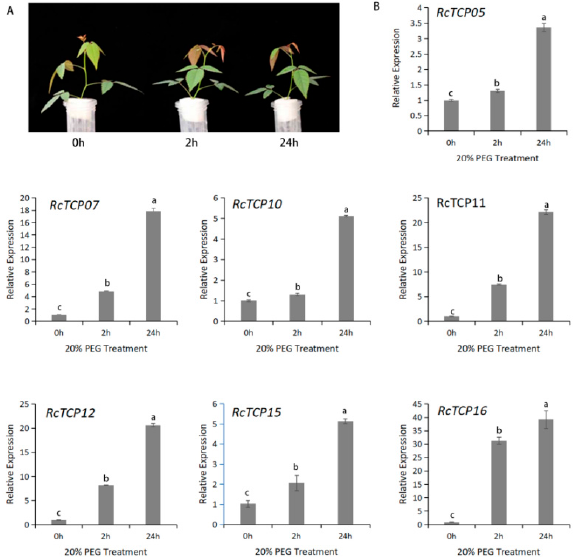
Figure 7. Expression patterns of RcTCP genes under PEG treatments (determined by RT-qPCR). ( A ) The method of PEG treatments. ( B ) The expression of RcTCP genes under 0 h, 2 h and 24 h of PEG treatments determined by RT-qPCR. The RcGAPDH gene was used as the internal control, and three biological and technical replicates were conducted. The relative expression levels of each gene were calculated using the 2 − ∆∆ CT method. Each bar shows the mean ± SE of the triplicate assay, and different letters indicates significant difference at p < 0.05 according to Duncan’s multiple range